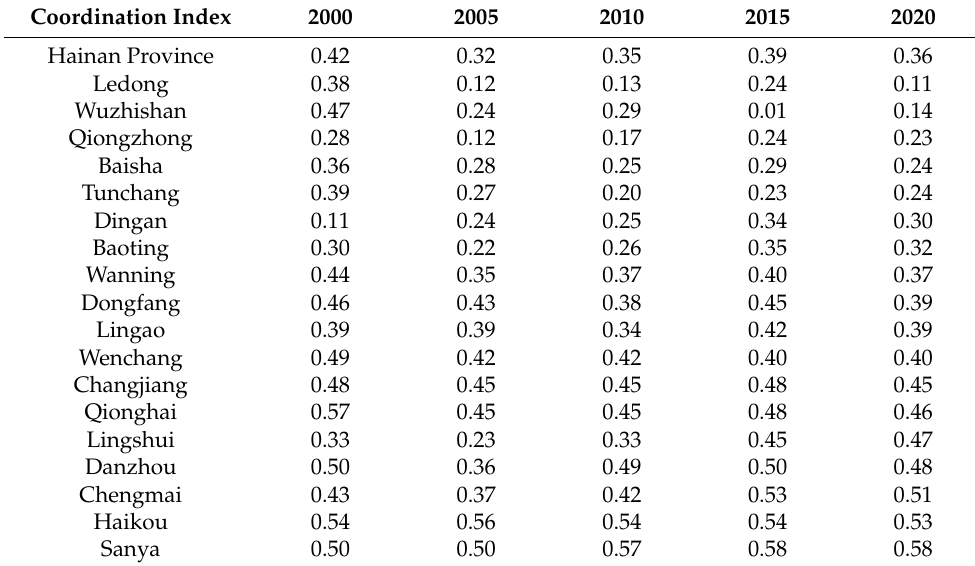
Table 12. Environmental and economic coordination index in Hainan.